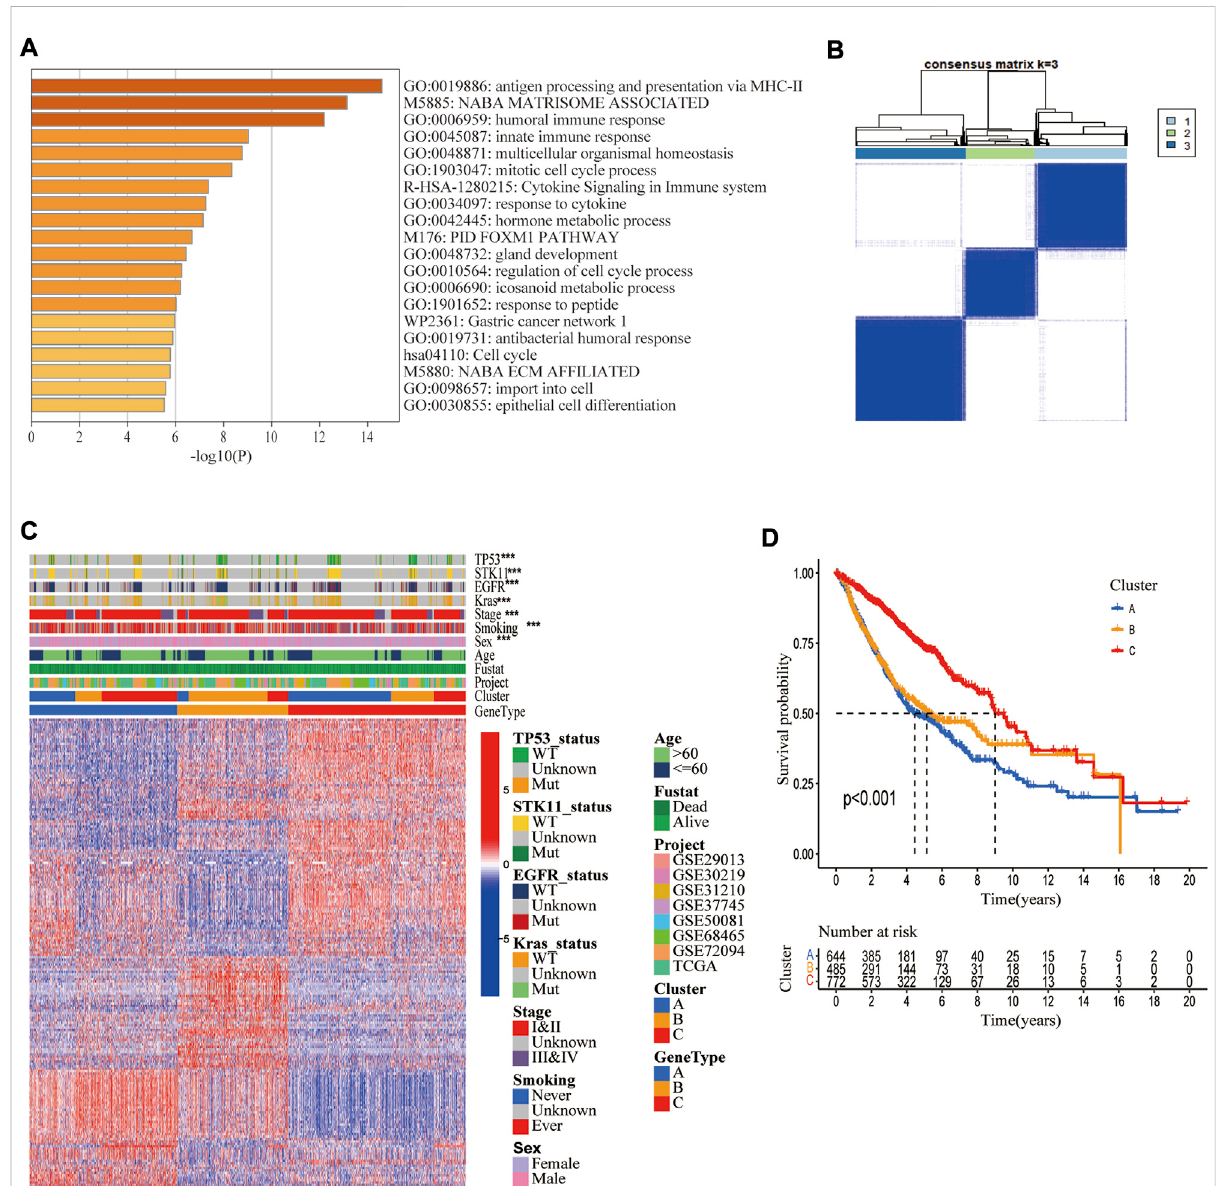
FIGURE 5 Identi fi cationofthreecuproptosis-relatedgeneticsubtypes. (A) Theenrichmentofbiologicalpathwaysbasedondifferentiallyexpressedgenes (DEGs) in three cuproptosismolecular subtypes. (B) The 1972 LUAD samples in the merged cohort were classi fi ed into three genetic subtypes based ontheseDEGsusingunsupervisedclusteringanalysis(k=3). (C) HeatmapshowingdifferencesinDEGsanddifferentclinicalfeaturesinthreegenetic subtypes. (D) Kaplan Meier Analysis showed differences in overall survival among three genetic subtypes.*, **, and ***, represent p < 0.05, p < 0.01, and p < 0.001,